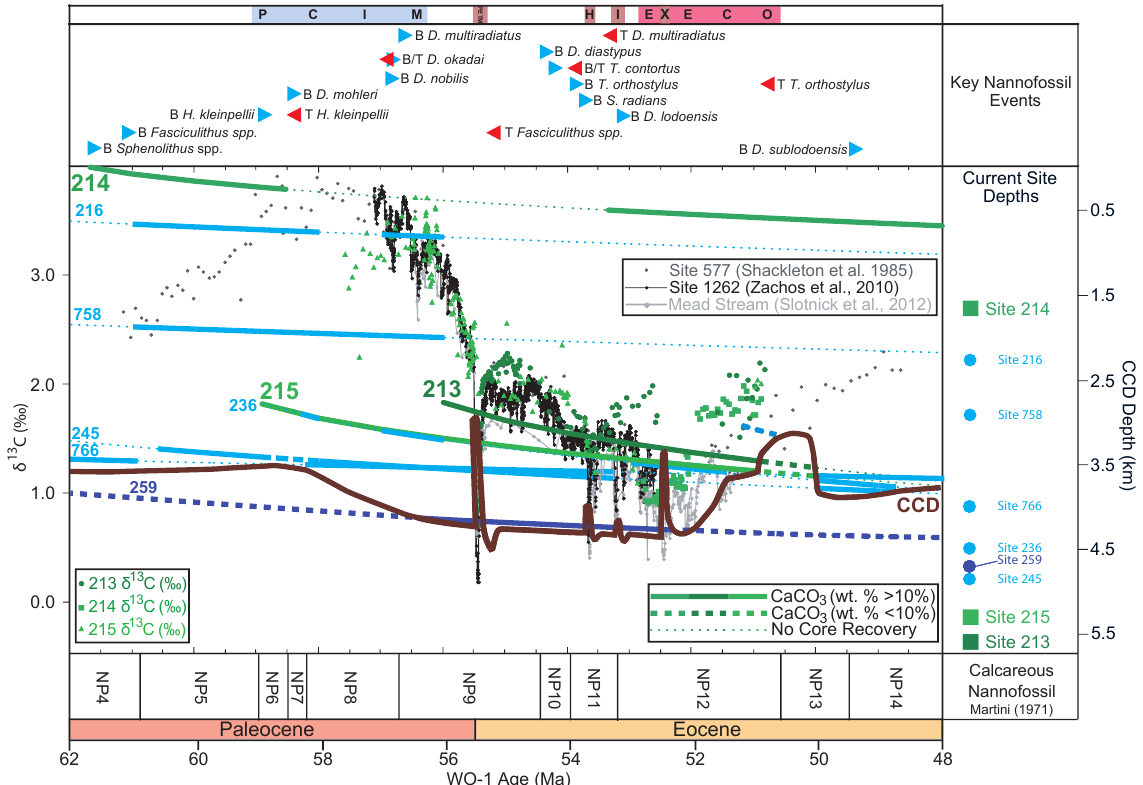
Figure 10. Bulk carbonate δ 13 C records and calcareous intervals for several locations placed onto a current timescale (Option 1; Westerhold et al., 2008). Stable isotope records include those at DSDP Site 577 (North Pacific; Shackleton et al., 1985), ODP Site 1262 (central Atlantic; Zachos et al., 2010) and Mead Stream (South Pacific; Slotnick et al., 2012). Subsidence curves for Sites 213 and 215 (various shades of green) and for Sites 236, 245, and 766 (Shipboard Scientific Party, 1974b; Shipboard Scientific Party, 1974c; Shipboard Scientific Party, 1990 – light blue) were calculated using a slightly modified version of the mid-ocean ridge subsidence curve from Rea and Lyle (2005). Subsidence curves for Site 214 (green) and for Sites 216 and 758 (Shipboard Scientific Party, 1974a; Shipboard Scientific Party, 1989c – light blue) follow established guidelines for aseismic ridges (Detrick et al., 1977). Plotted curves, when solid, indicate carbonate contents > 10%, but when dashed they indicate carbonate contents < 10%. Importantly, curves are lightly dotted when no data are available. The dark-brown solid line denotes reconstructed CCD following new carbonate content data. The biozonal scheme adopted is that of Martini (1971). Ages of calcareous nannofossil biohorizons are those proposed by Agnini et al. (2006, 2007) recalibrated using Option 1 of Westerhold et al.